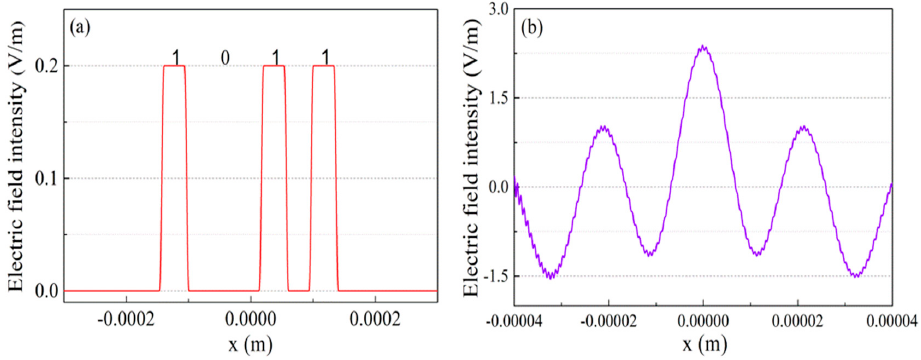
Figure 4. ( a ) The object message E ( x ) e.g., “1011”. ( b ) The electric field amplitude U O .